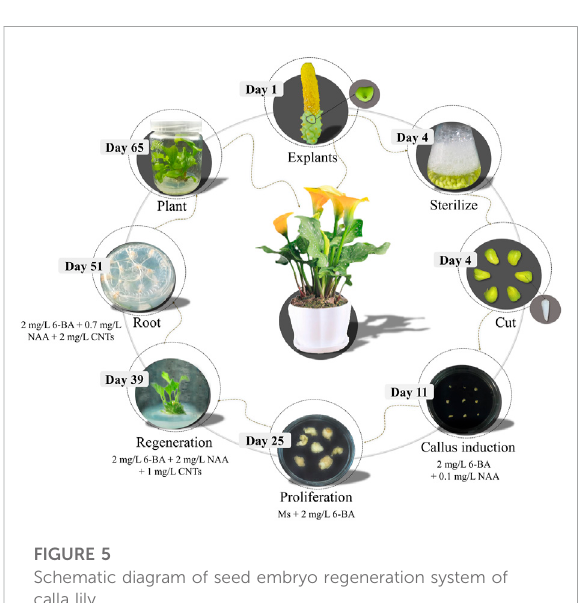
FIGURE 5 Schematic diagram of seed embryo regeneration system of calla